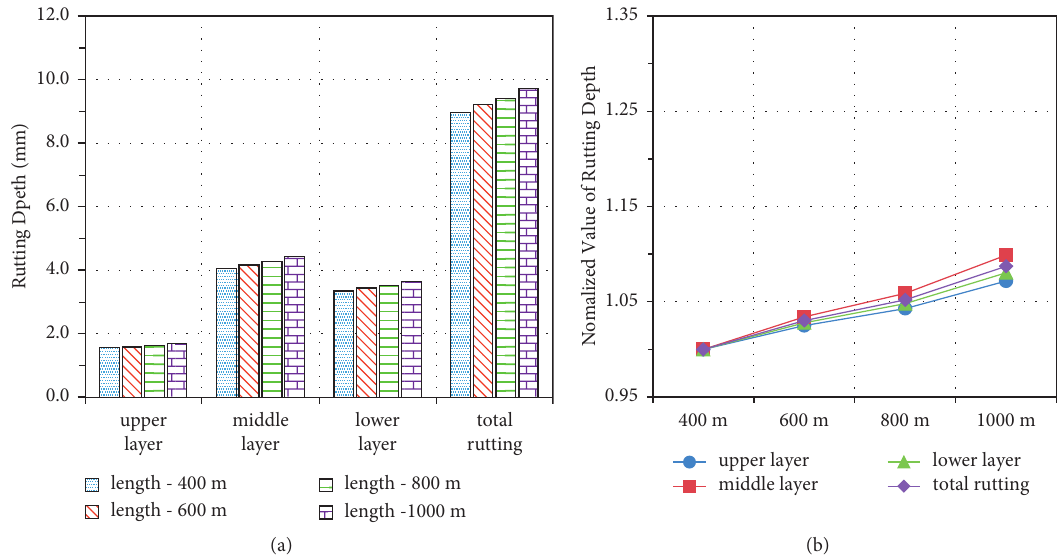
Figure 16: Rutting depth under different slope lengths: (a) normal value and (b) standardized value.